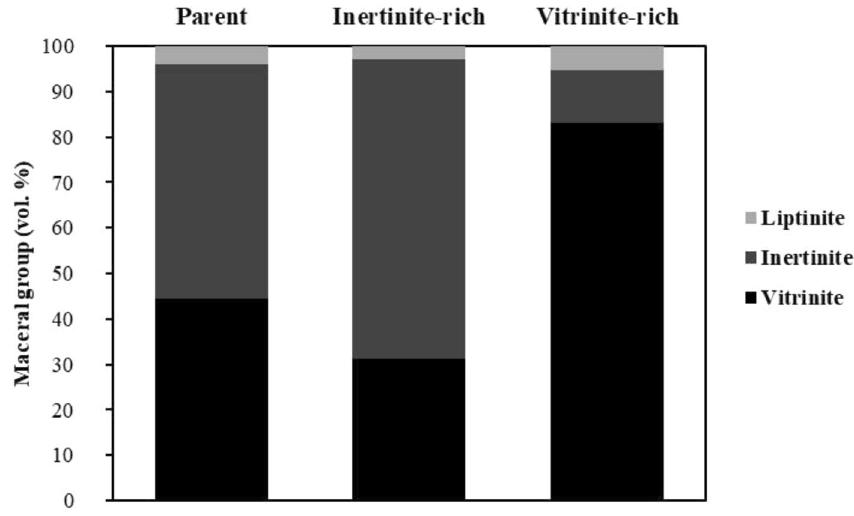
Fig. 1 Distribution of maceral groups (mineral-matter-free basis) for the parent, inertinite-rich and vitrinite-rich